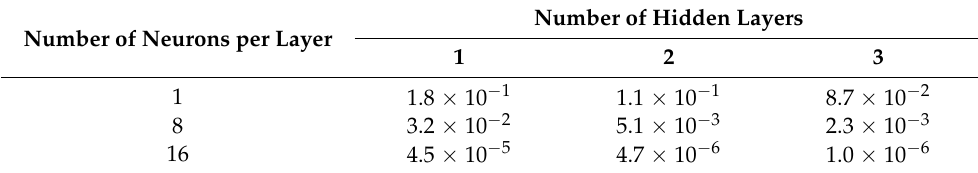
Table 5. Total model losses for different architectures for the recuperated Brayton cycle. Number of Neurons per Layer